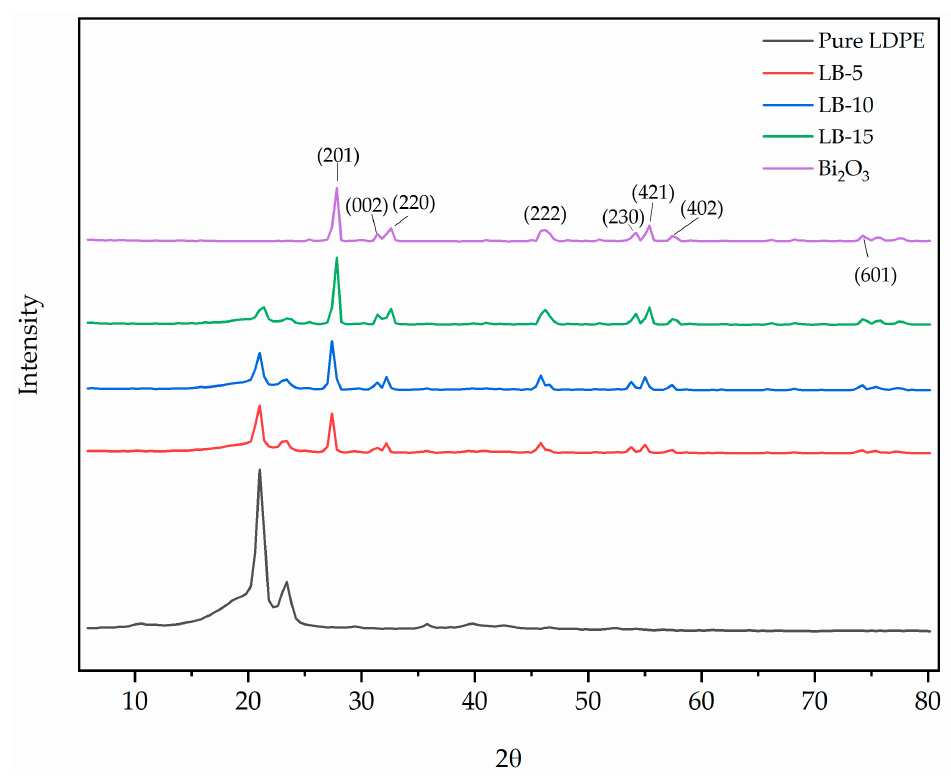
Figure 3. XRD patterns of pure LDPE, Bi 2 O 3 and its composites. Table 5. Crystallite size of the LDPE composites.